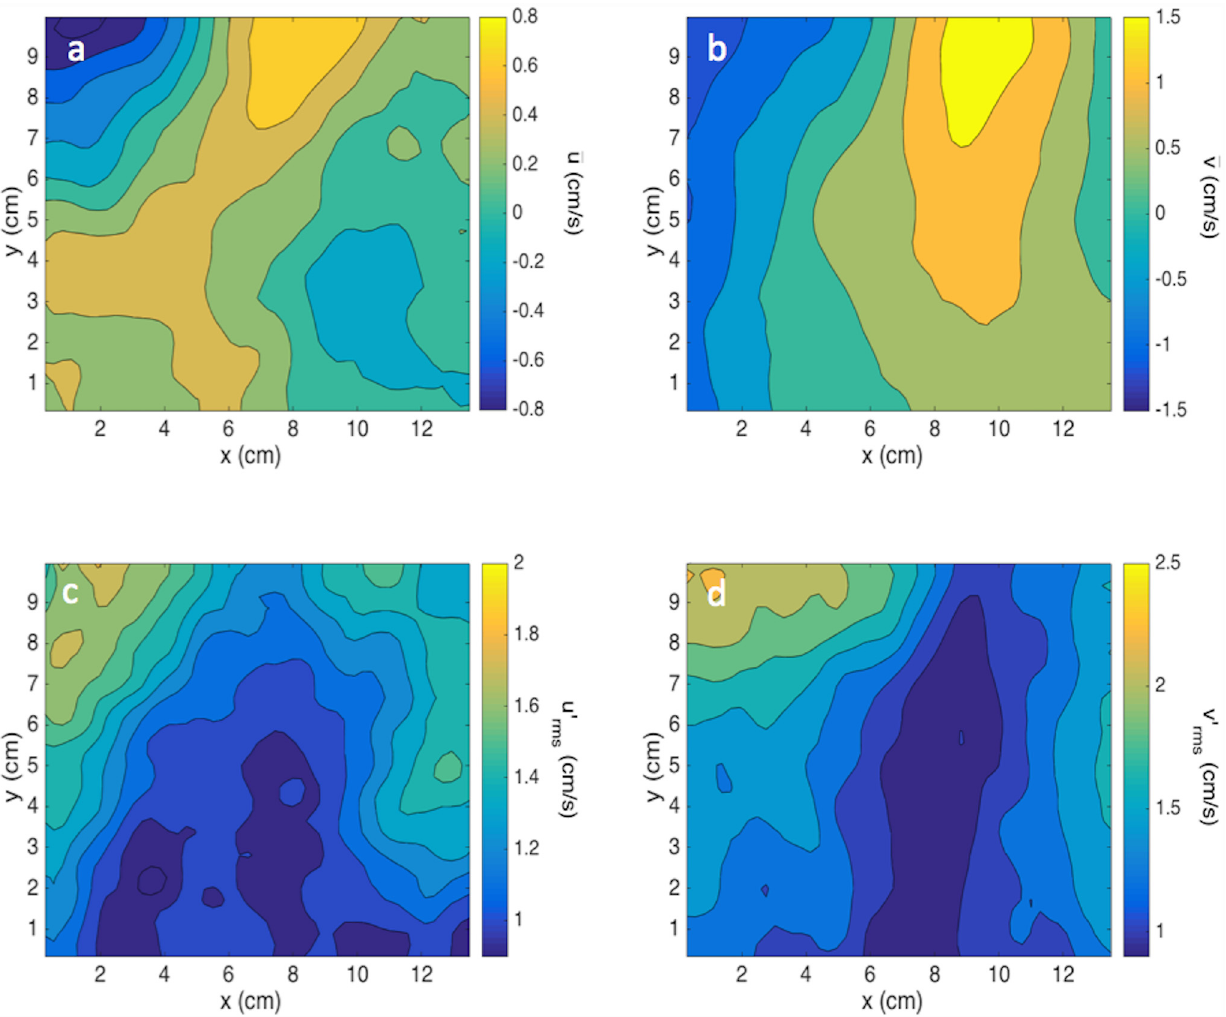
Fig 4. Sample contour maps of (a) mean horizontal velocity, (b) mean vertical velocity, (c) RMS of horizontal fluctuating velocity and (d) RMS of fluctuating vertical velocity at 6 Hz grid